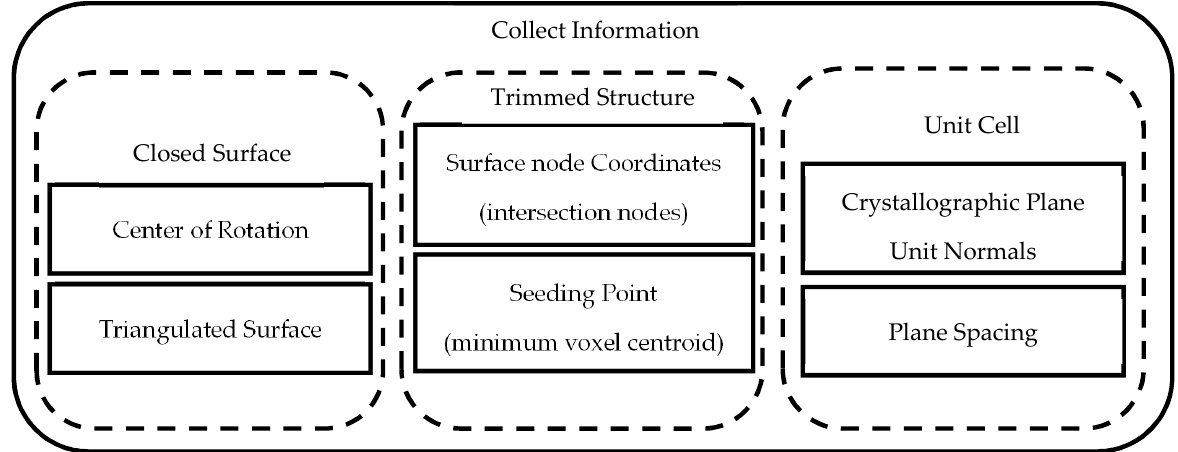
Figure 6. Input information for lattice net generation.